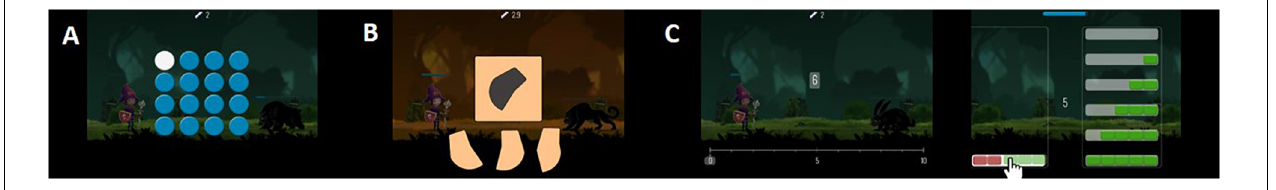
FIGURE 1 | The screenshots for the training games: visual-spatial working training (A) , mental rotation training (B) , and mathematical training (C) .